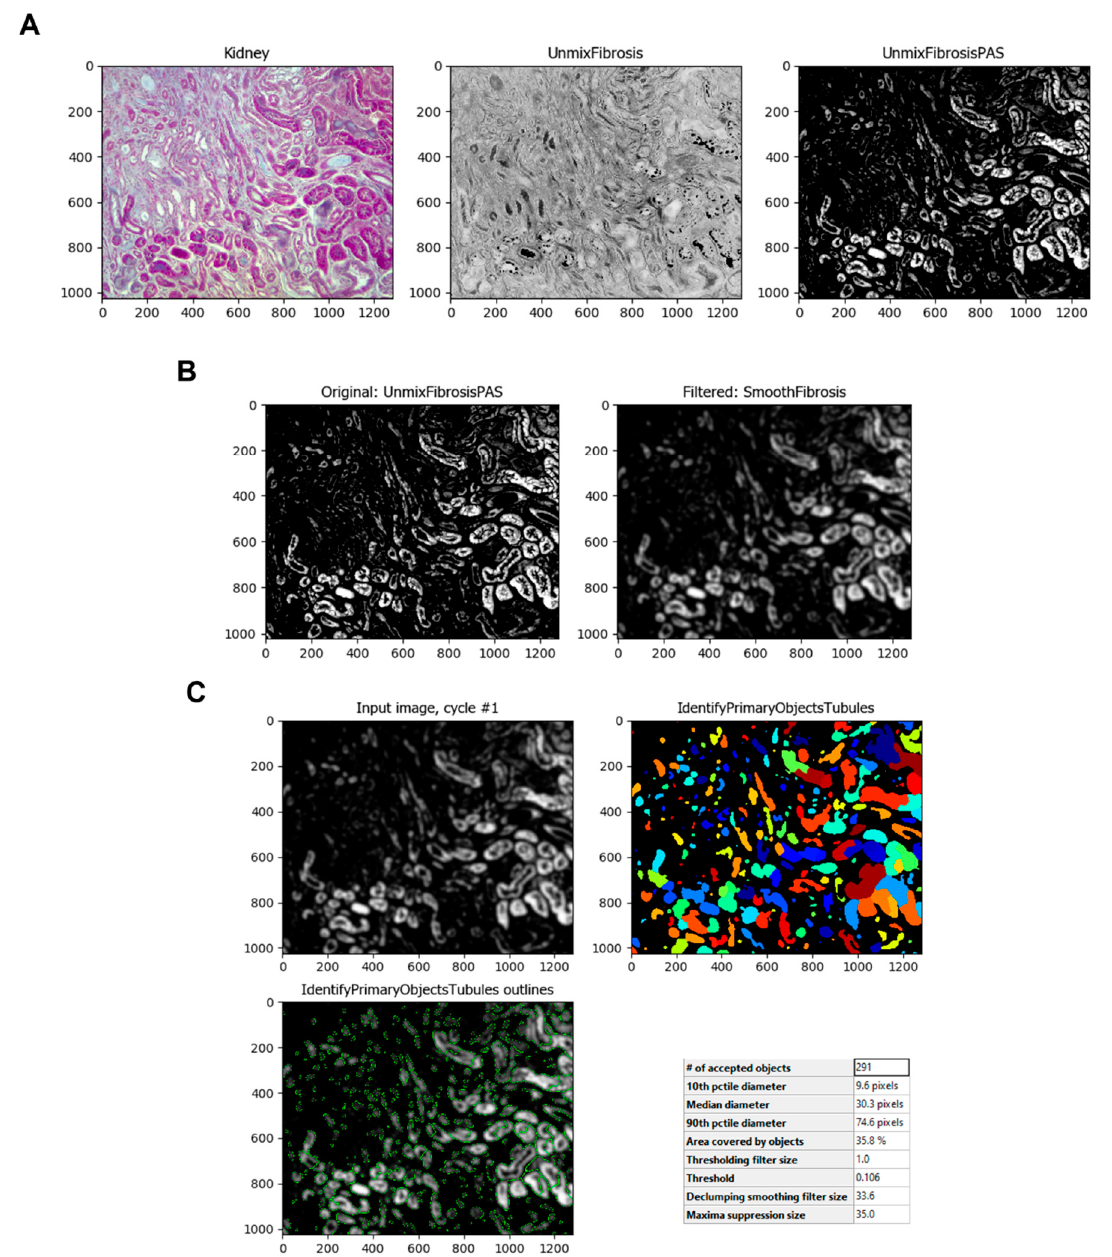
Figure 3. Identification of tubules. ( A ) The UnmixColors module separates the image of one or more stains (here, Hematoxylin and PAS as primary and PAS as secondary). ( B ) The UnmixColors module separates the image of one or more stains (here, Hematoxylin and PAS as primary and PAS as secondary). ( C ) The IdentifyPrimaryObjects module is used to identify cell structures, in this case, it is used for the identification of kidney tubules.